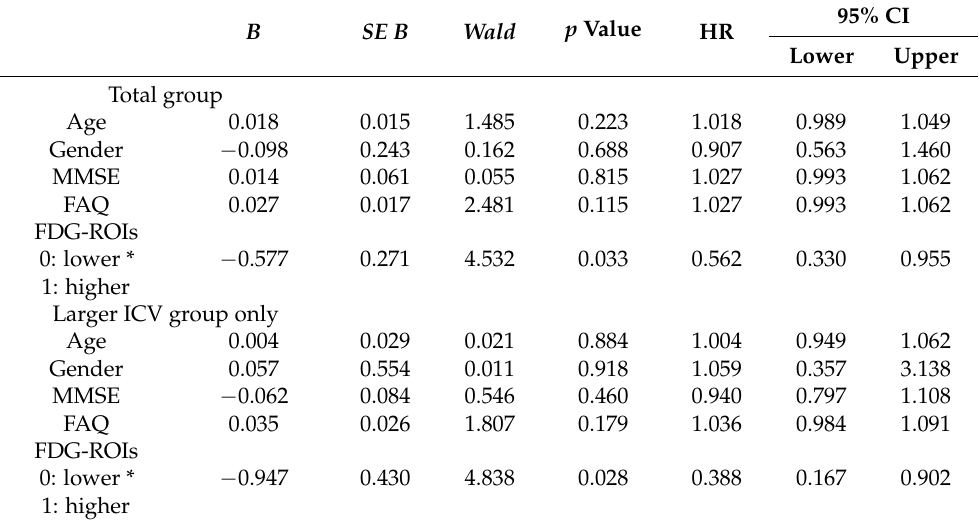
Table 2. Results of multivariate Cox proportional hazard model.